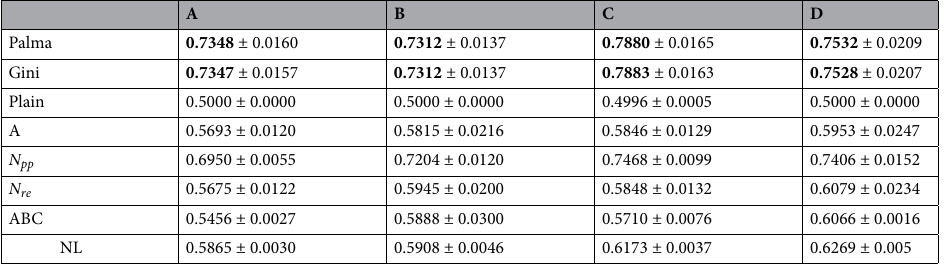
Table 4. AUROCs for HAM10000 with the following setups: A—diverse outliers, diverse inliers, B—diverse outliers, homogeneous inliers, C—homogeneous outliers, homogeneous inliers, D—homogeneous outliers, diverse inliers. The best and the second-best results are in